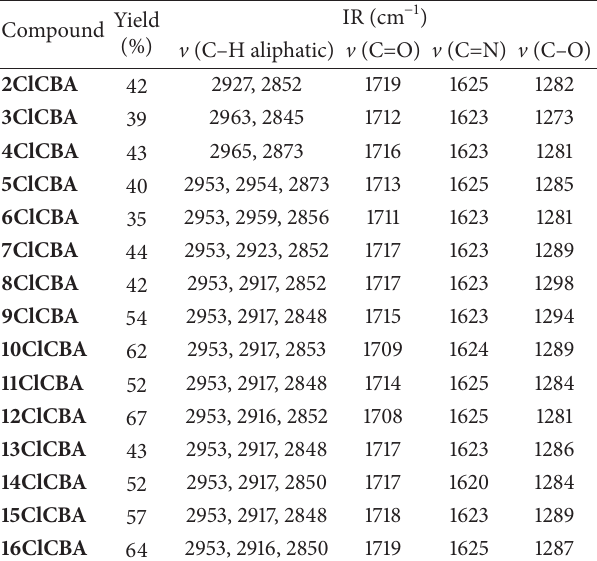
Table 1: Percentage yields and IR frequencies of alkyl 4- { [(4- chlorophenyl)imino]methyl } benzoates.